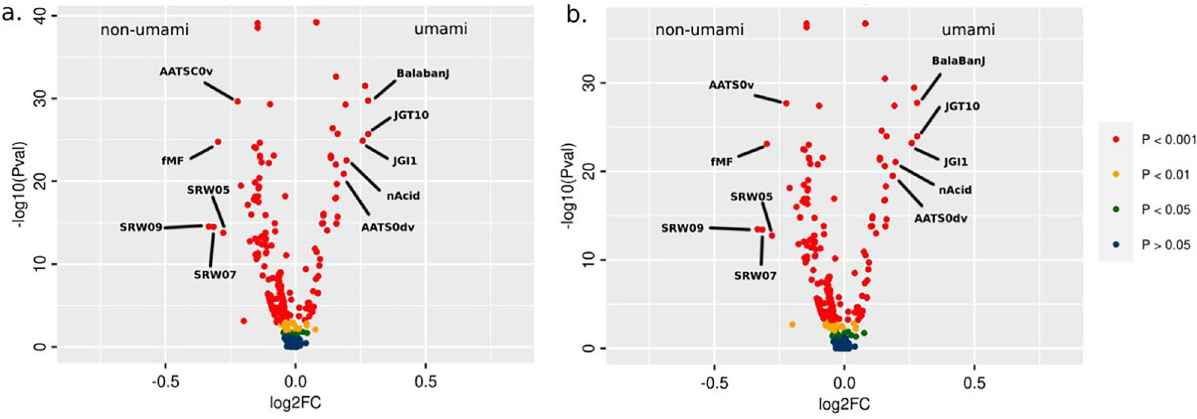
Figure 1. Volcano plots of the statistical analysis of the descriptors on the umami versus non-umami samples for the training set ( a ) with the standard limma eBayes method using p-values and ( b ) with correction of p-values using the Benjamini–Hochberg FDR adjustment method to calculate q-values. Only the 5 most upregulated and 5 most downregulated features are labelled for the sake of